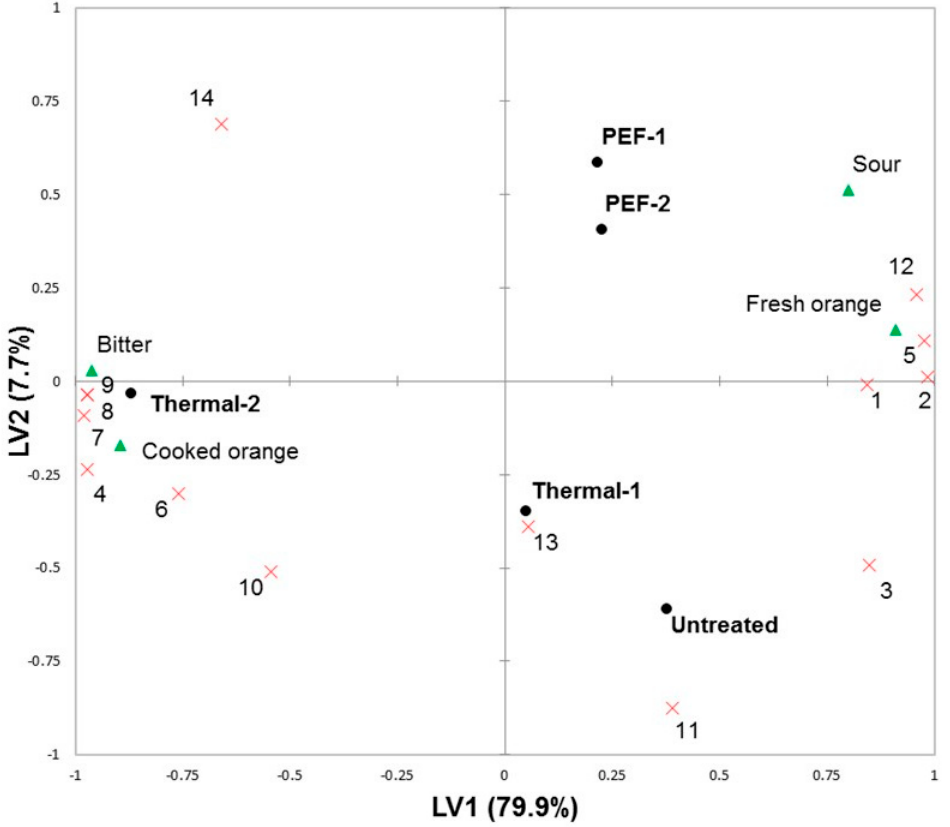
Figure 3. Partial least squares (PLS) regression map showing the relationship among the instrumental data correlated with sensory attribute data in all orange juice samples. The sensory parameters are explained in Table 1 and the compound codes are given in Table 2.